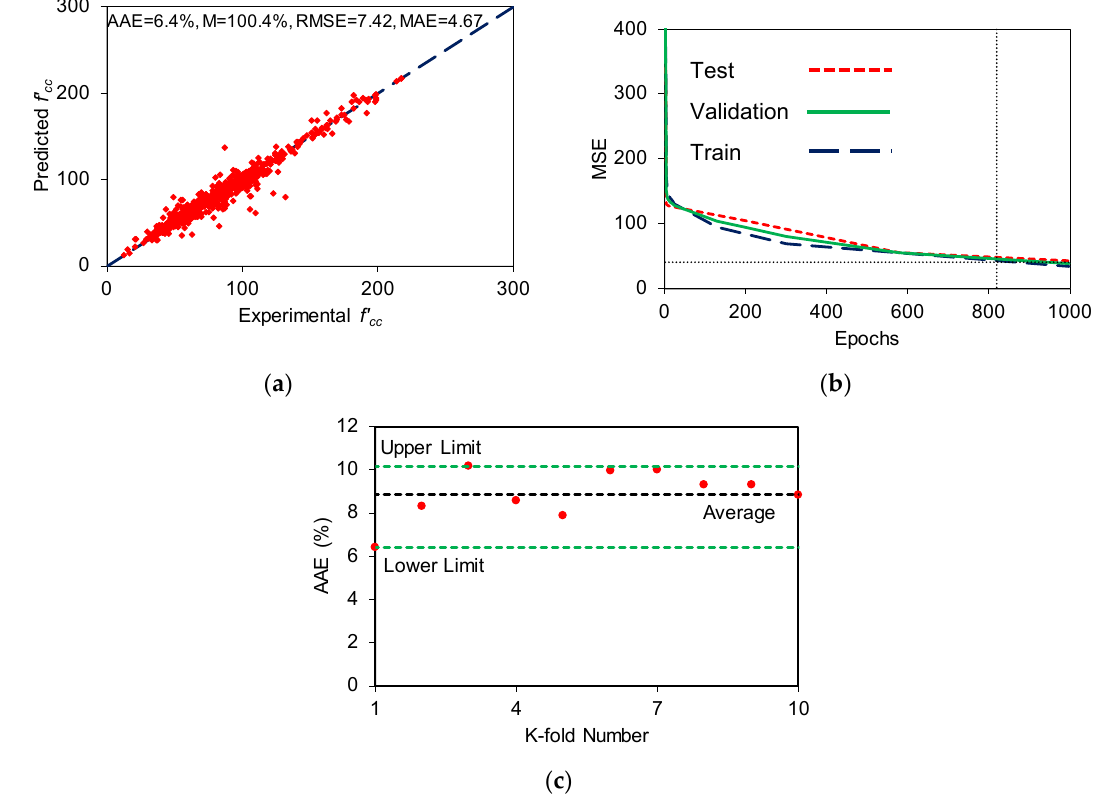
Figure 4. Performance of a developed model for compressive strength ( f’ cc ): ( a ) Comparison of model prediction and experimental values, ( b ) performance accuracy, and ( c ) cross-validation analysis. Table 7. Summary of different studied cases for input variables for ε cu